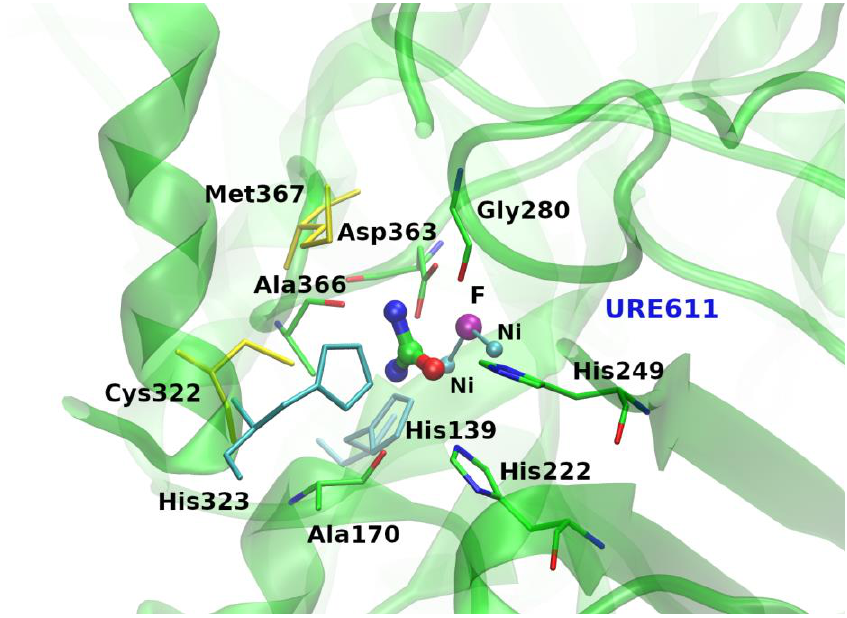
Figure 2. Binding site of the Sporosarcina pasteurii urease protein (PDB ID: 6qdy [35]) where urea makes the largest number of contacts. Hydrogen bonds with main and side chains of both aliphatic and hydrophobic amino acids, nonpolar interactions with protein atoms as well as with ions stabilize urea (URE611) in the present binding site. Yellow and cyan sticks represent aliphatic and aromatic van der Waals-type contacts, respectively.